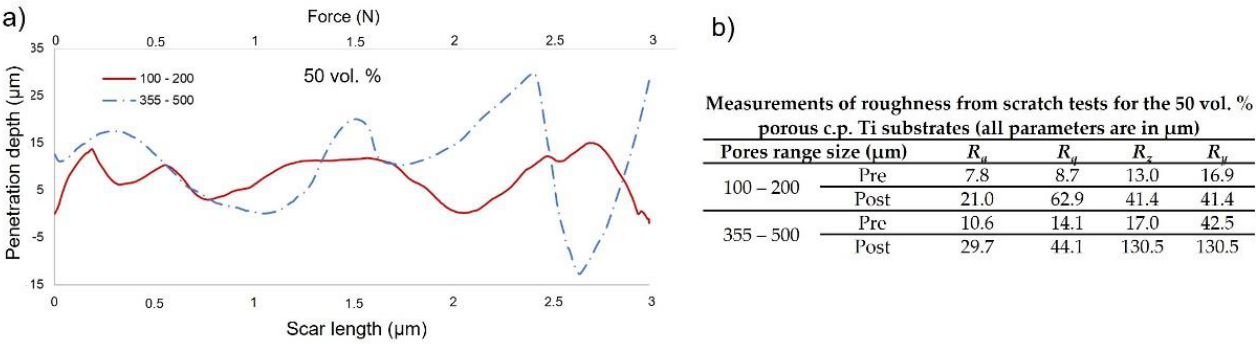
Figure 8. ( a ) Roughness profile measured before the scratch and ( b ) characteristic roughness parameters before and after the scratch